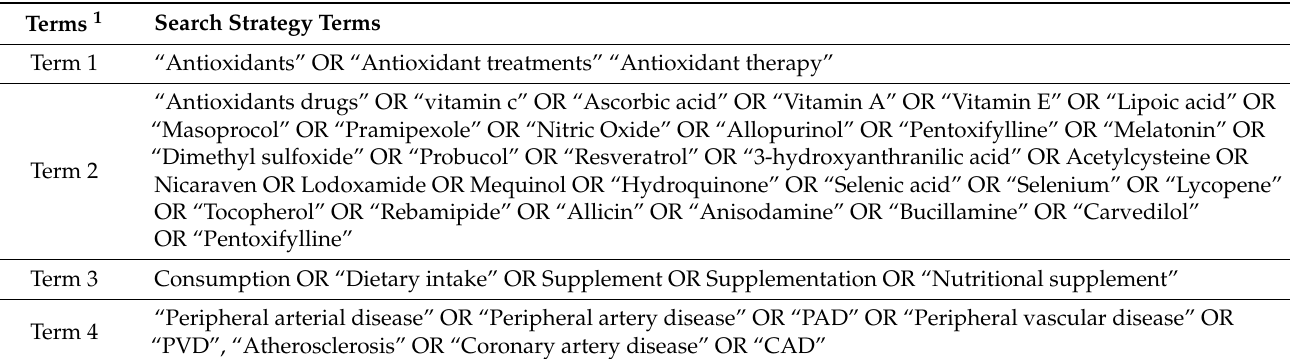
Table 1. Full details of the search strategy